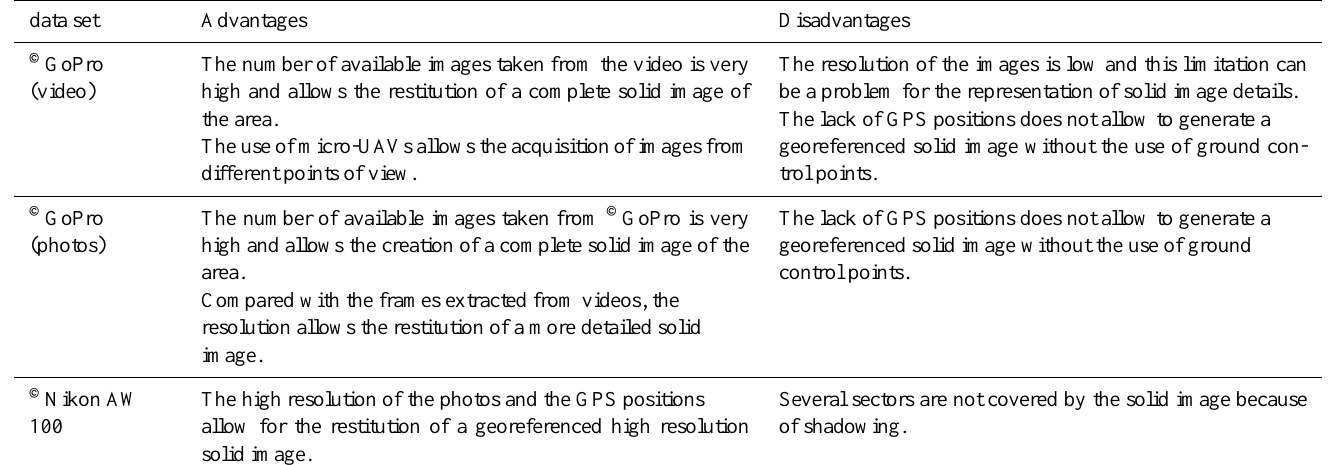
Table 2. Comparison between the results obtained for the San Germano case study. data set